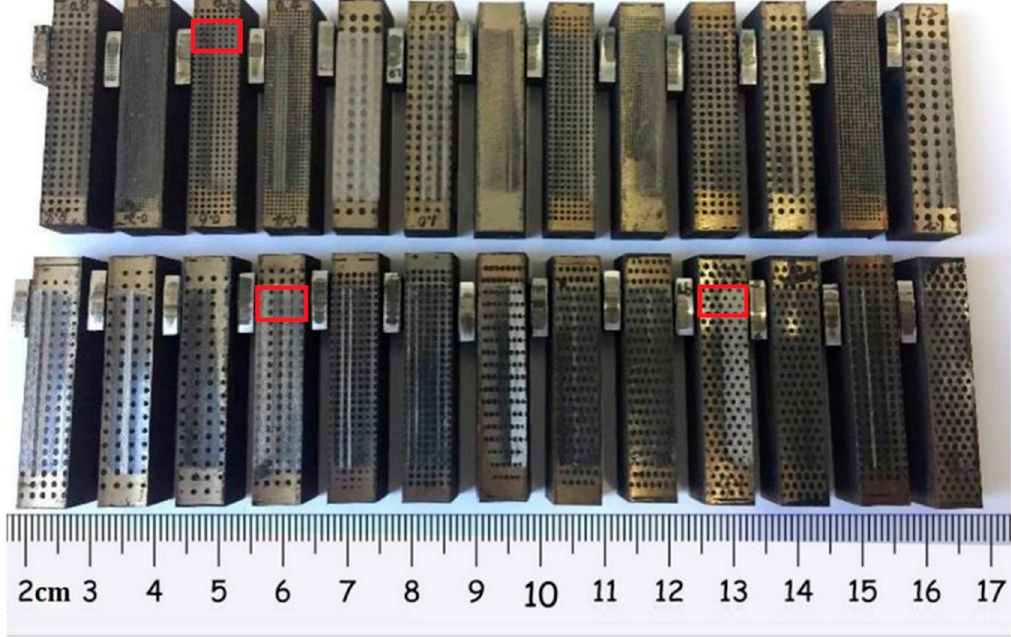
Figure 7. The typical tested PRCL samples.